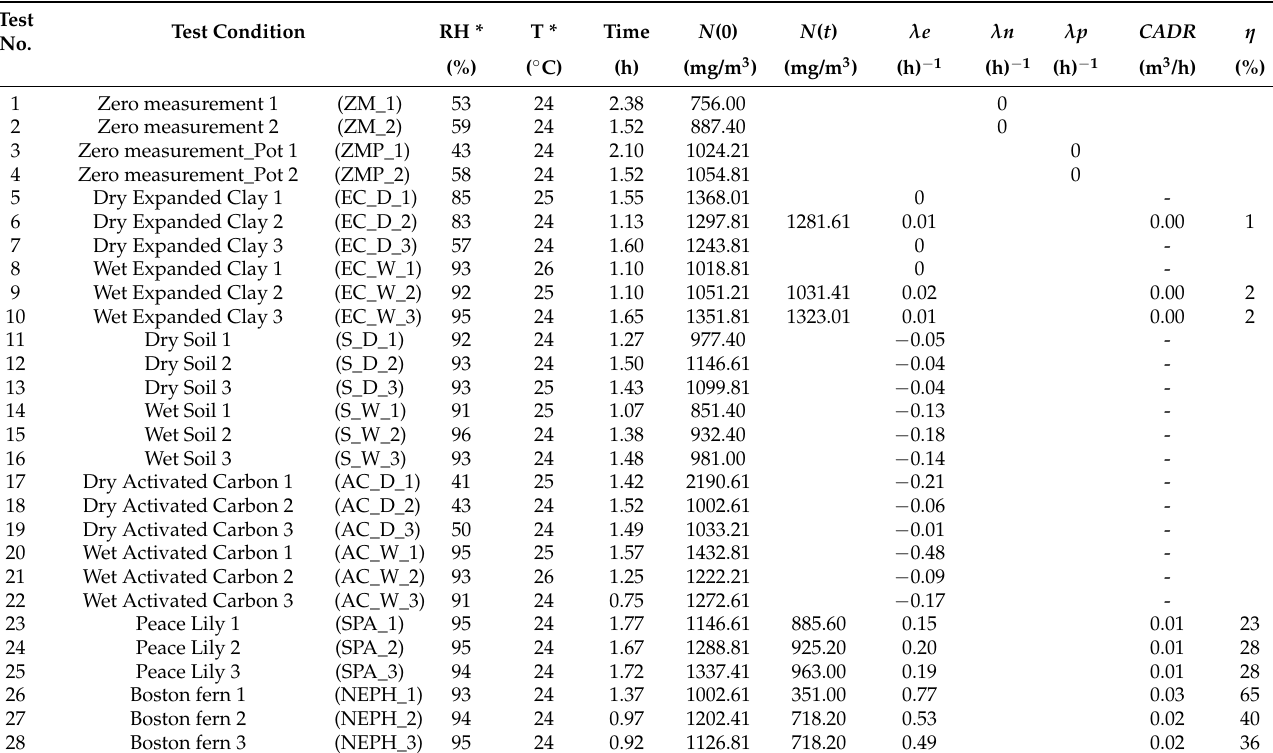
Table 2. CADR of CO 2 depletion inside of the chamber.